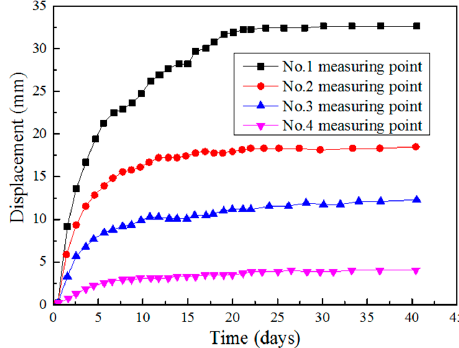
Figure 10. Time history plots of the internal displacements in class V rock masses at position B in the K89+729 section.